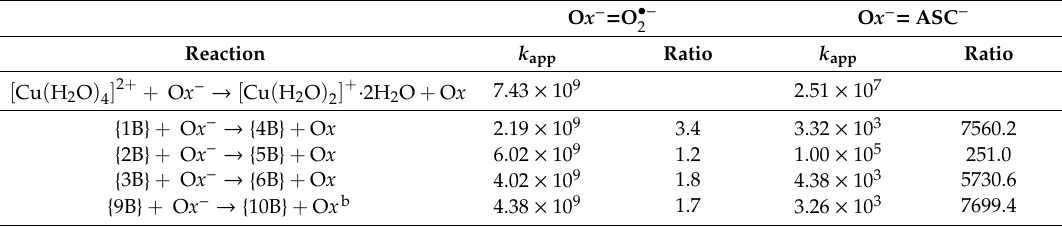
•− − and with ascorbate (ASC ) in aqueous solution at 298.15 K 2